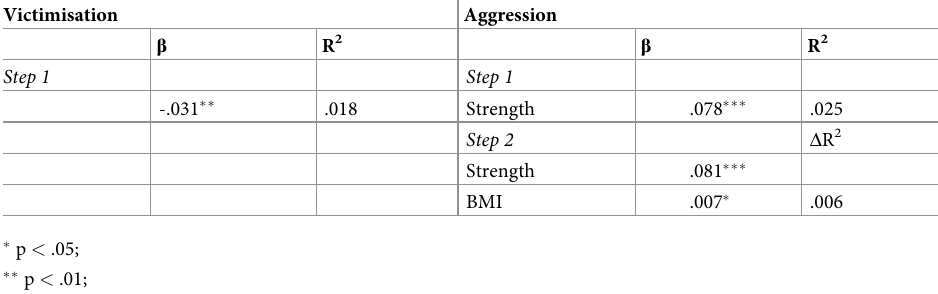
Table 6. Stepwise regression analysis with gender, age, BMI, strength and cardiorespiratory fitness as cross-sec- tional predictors of victimisation and aggression.